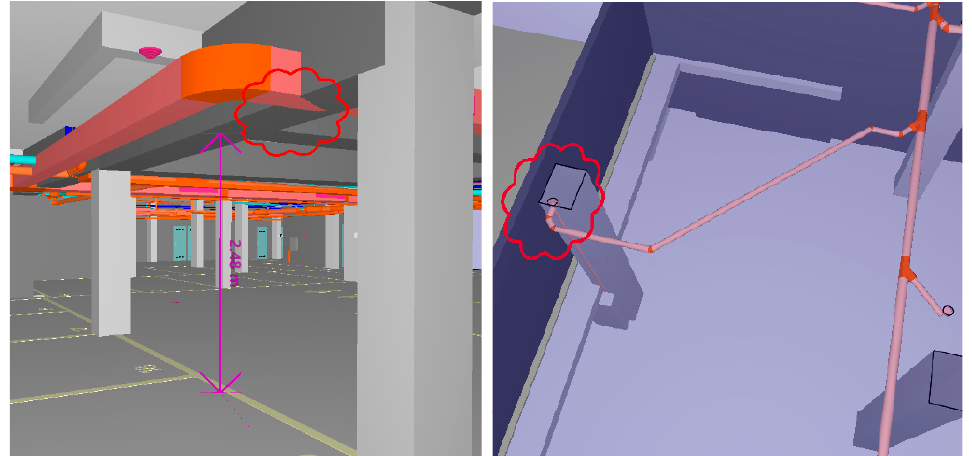
Figure 6. Virtual representation of collision between structural elements and facilities. Ventilation ducts and beam ( left ) and plumbing pipeline and pilar ( right ). BIM Model.